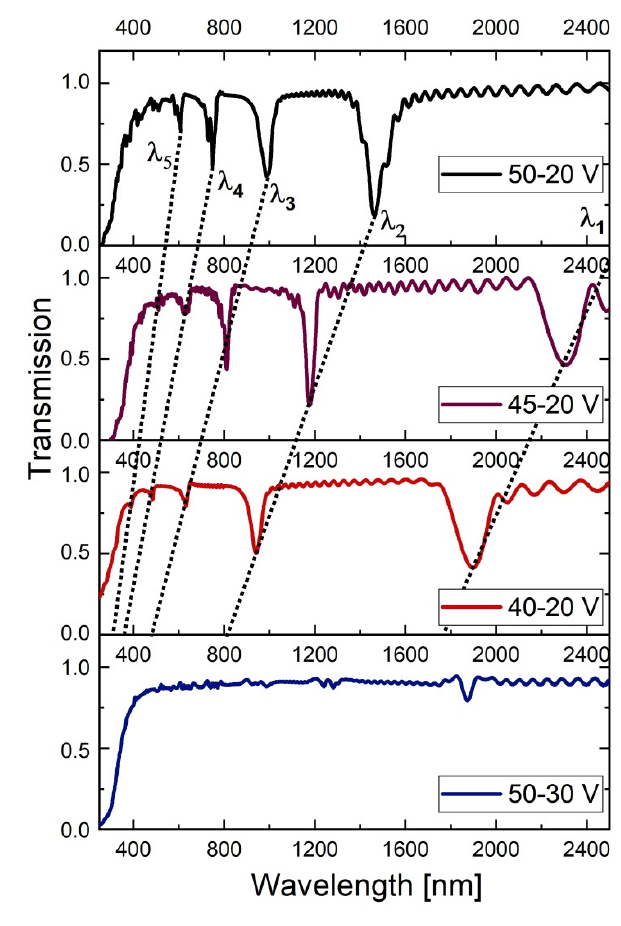
Figure 10. Transmittance spectra of PAA-based DBR fabricated at 10 °C under various U H and U L values.